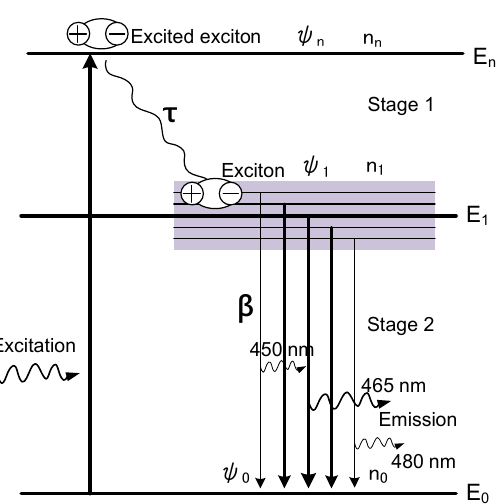
Figure 3. Schematic illustration of excitation, energy relaxation time τ and radiative recombination time β of an exciton in the perovskite NCs .